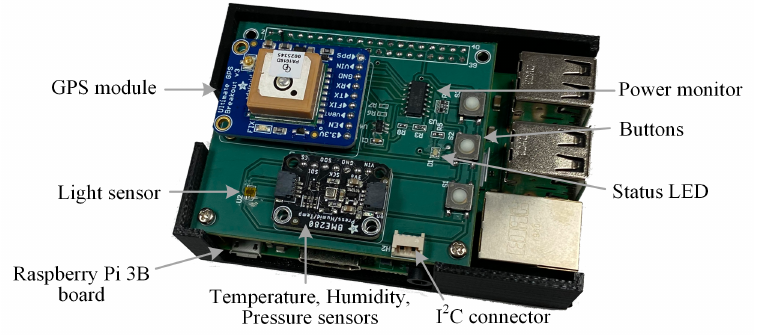
Figure 4. Remote data station, which is an aggregator between the cluster and the